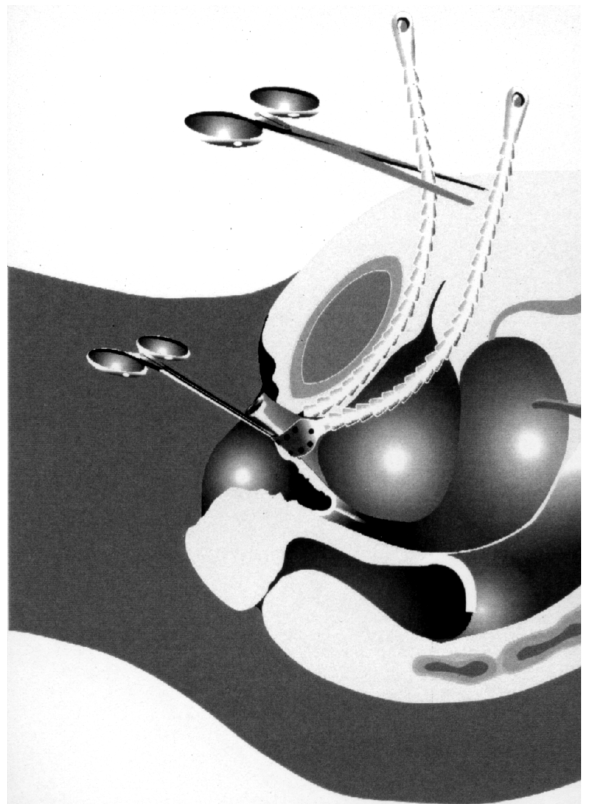
Figure 5 - The final aspect of the sling in